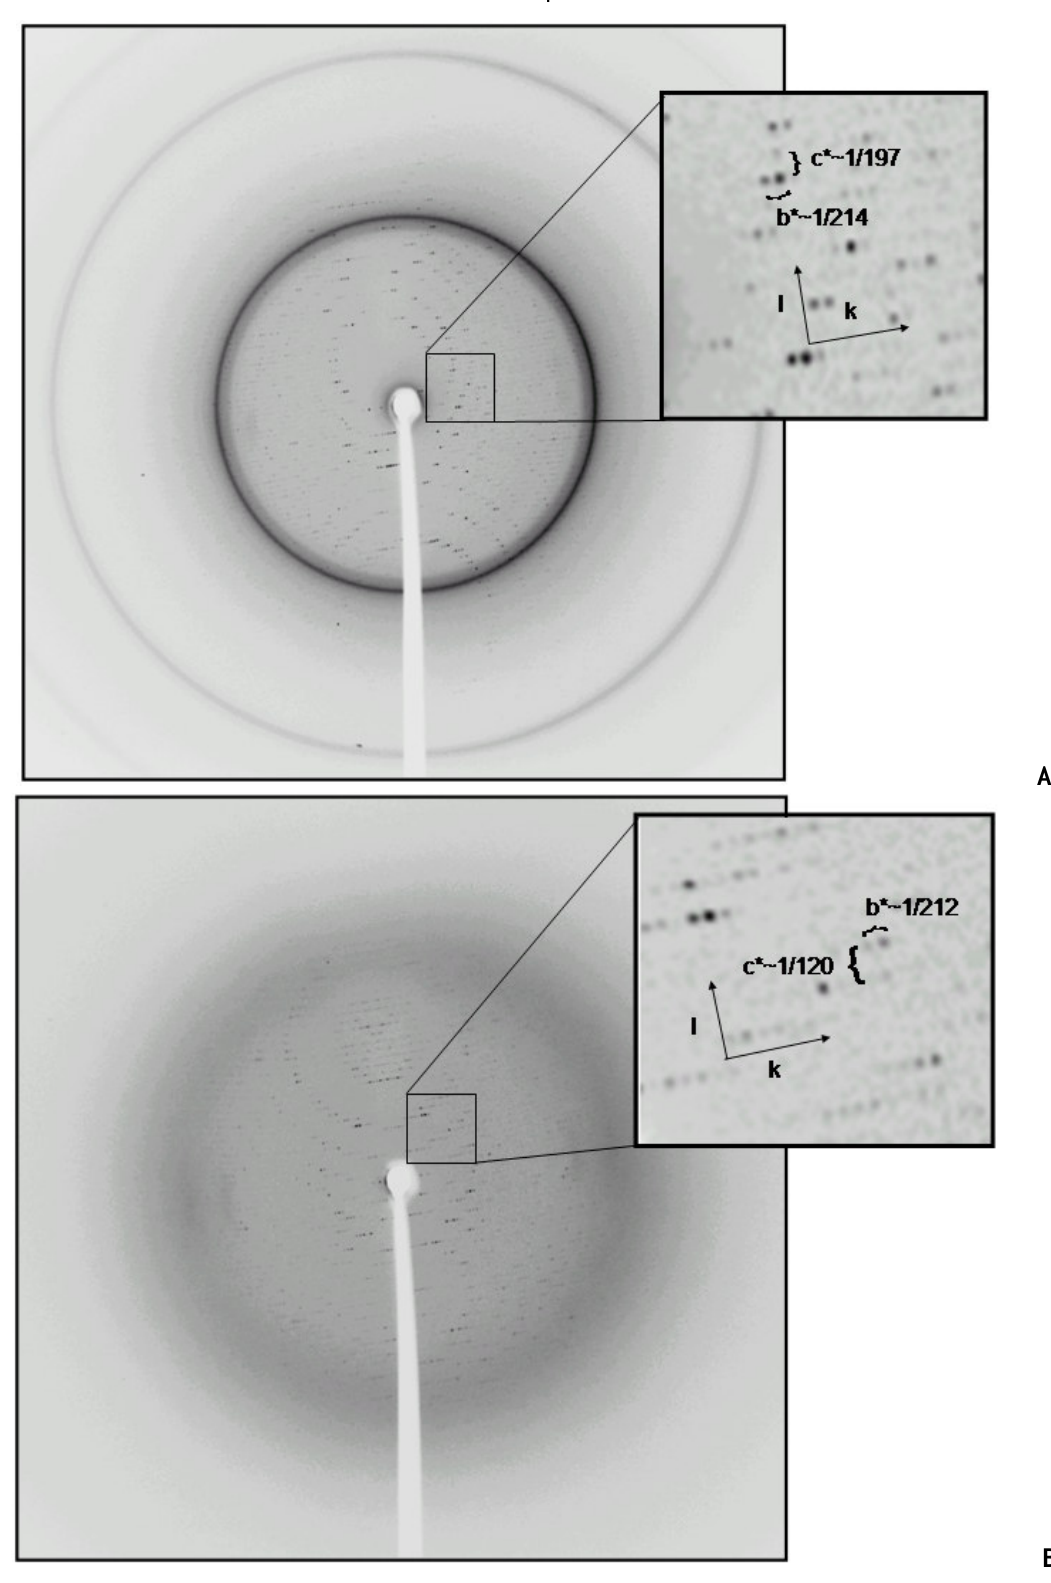
Figure 2. Representative examples of diffraction images for both P2 crystal forms: (A) 1 crystal form 2a, (B) crystal form 2b. The resolution at the edge of the frame corresponds to d~2Å. The maximal resolution of form 2a extends to ~2.4Å, while for form 2b to ~2.7Å. The insets show the arrangement of the lattices and the approximate relationships between the reciprocal